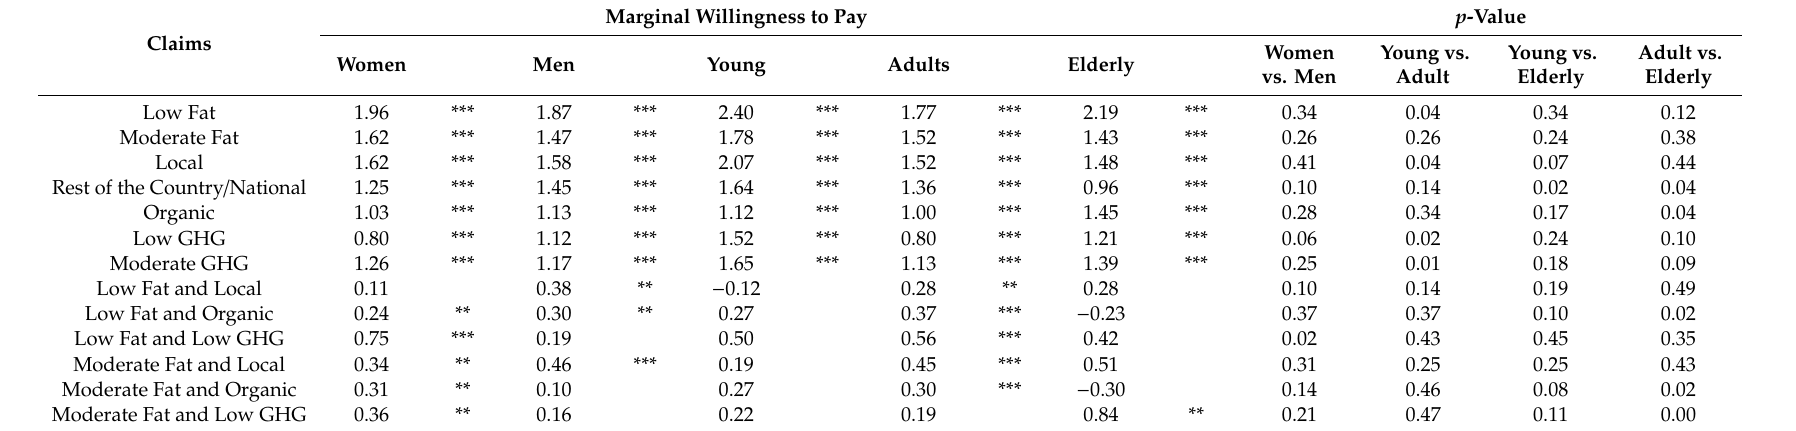
Table 5. Heterogeneity of consumers’